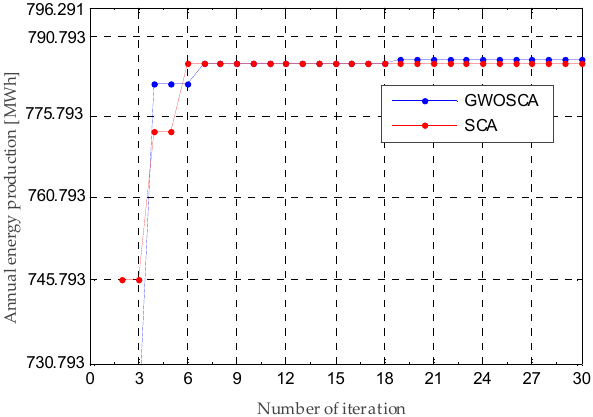
Figure 12. Convergence of the optimisation of annual energy using HGWOSCA algorithm for semi-hourly data.